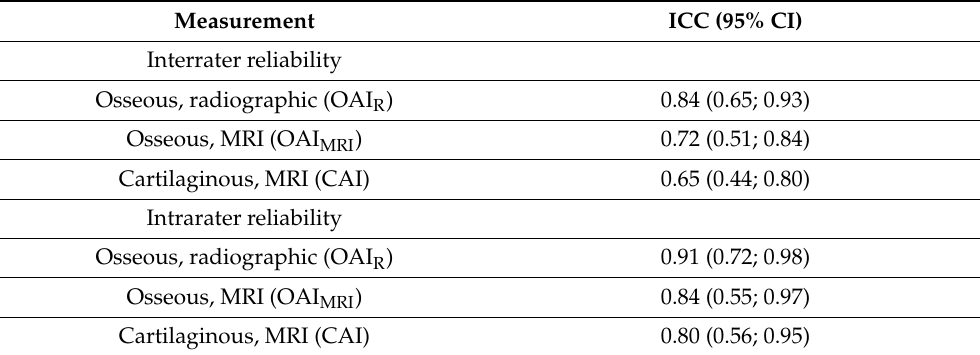
Table 1. ICC values for inter- and intrarater reliability with 95% bootstrap confidence